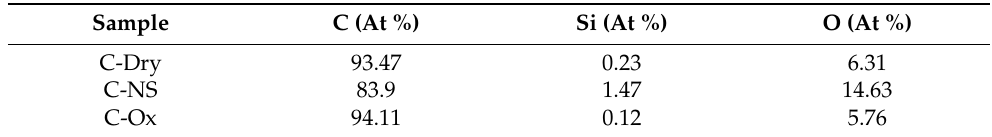
Table 6. Atomic percentages of carbon, silicon and oxygen detected by EDX analyses on the surfaces of the yarns C-Dry, C-NS and